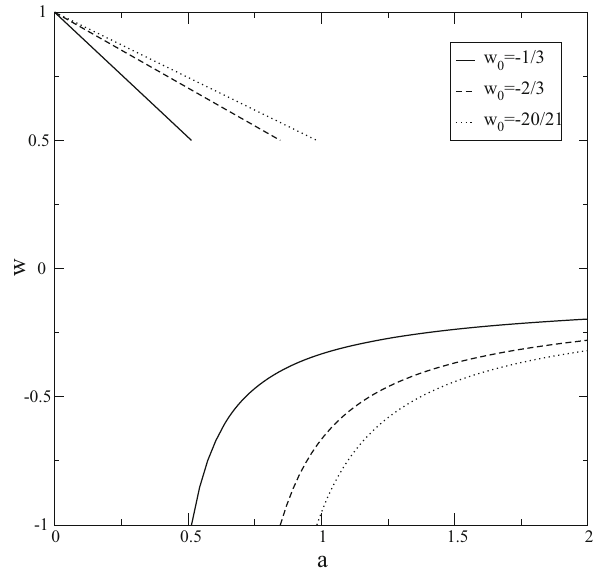
Fig. 1 Examples of quintessential EoS parameters satisfying the ther- modynamic conditions except at a point where w is not differentiable